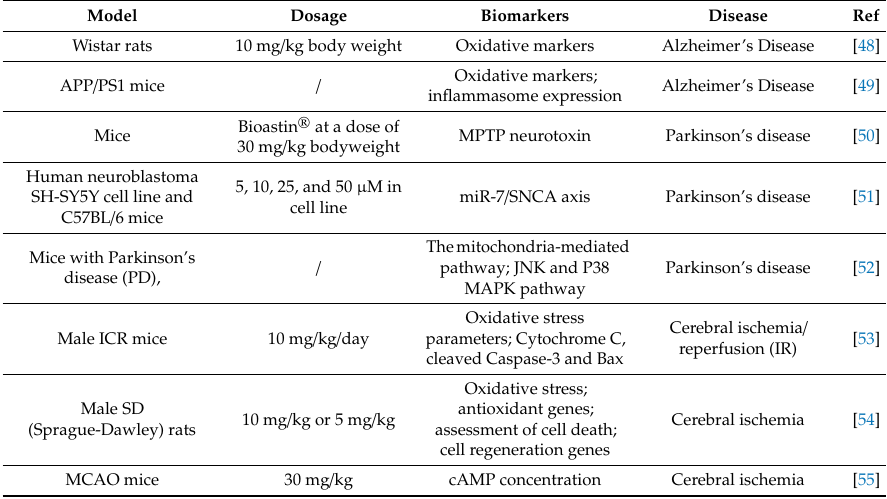
Table 1. The anti-inflammatory e ff ects of astaxanthin in neurological